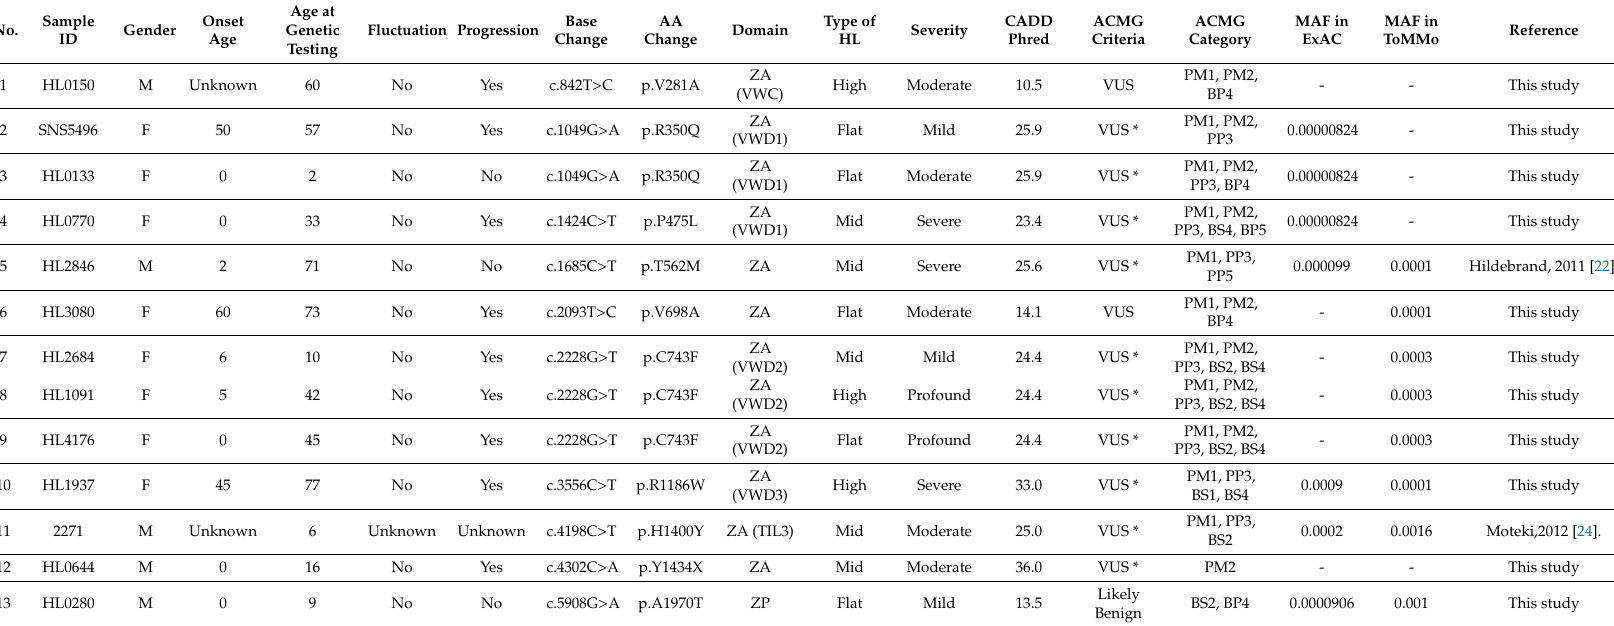
Nucleotide and protein positions of TECTA variants are according to RefSeq: NM_005422. M: Male, F: Female, AA: Amino acid, NIDO: Nidogen-like domain, ZA: Zonahesin-like domain, VWC: Von Willebrand factor C domain, TIL: Trypsin inhibitor-like domain, VWD: Von Willebrand factor D domain, ZP: Zona pellucida domain, MAF: Minor allele frequency. * ACMG category indicates the evidence for each variant